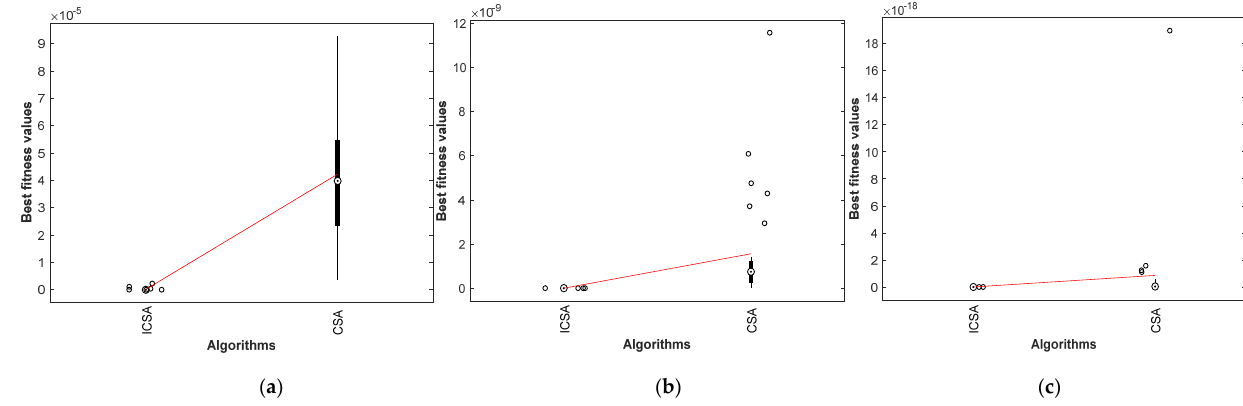
Figure 28. Boxplot of CSA and ICSA for various test cases: ( a ) Boxplot for F7; ( b ) Boxplot for F8; ( c ) Boxplot for F9.